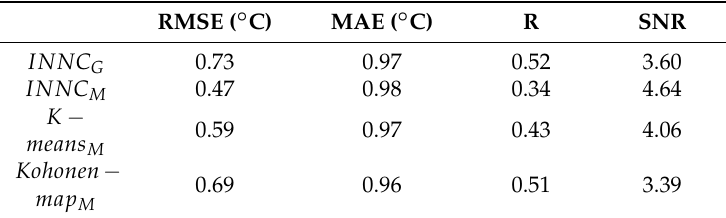
Figure 4. Reconstructed SST increments on 18 June 2014 obtained by using ( a ) Gaussian function and ( b ) multi-quadric function. White areas are lands in the images. Table 1. Statistical results from different basis functions and clustering methods on 13 June 2014. The subscripts G and M stand for Gaussian function and multi-quadric function, respectively. RMSE ( ◦ C) MAE ( ◦ C) R SNR INNC G 0.66 Table 2. Statistical results from different basis functions and clustering methods on 18 June 2014. The subscripts G and M stand for Gaussian function and multi-quadric function, respectively. RMSE (°C) MAE (°C) R SNR 0.73